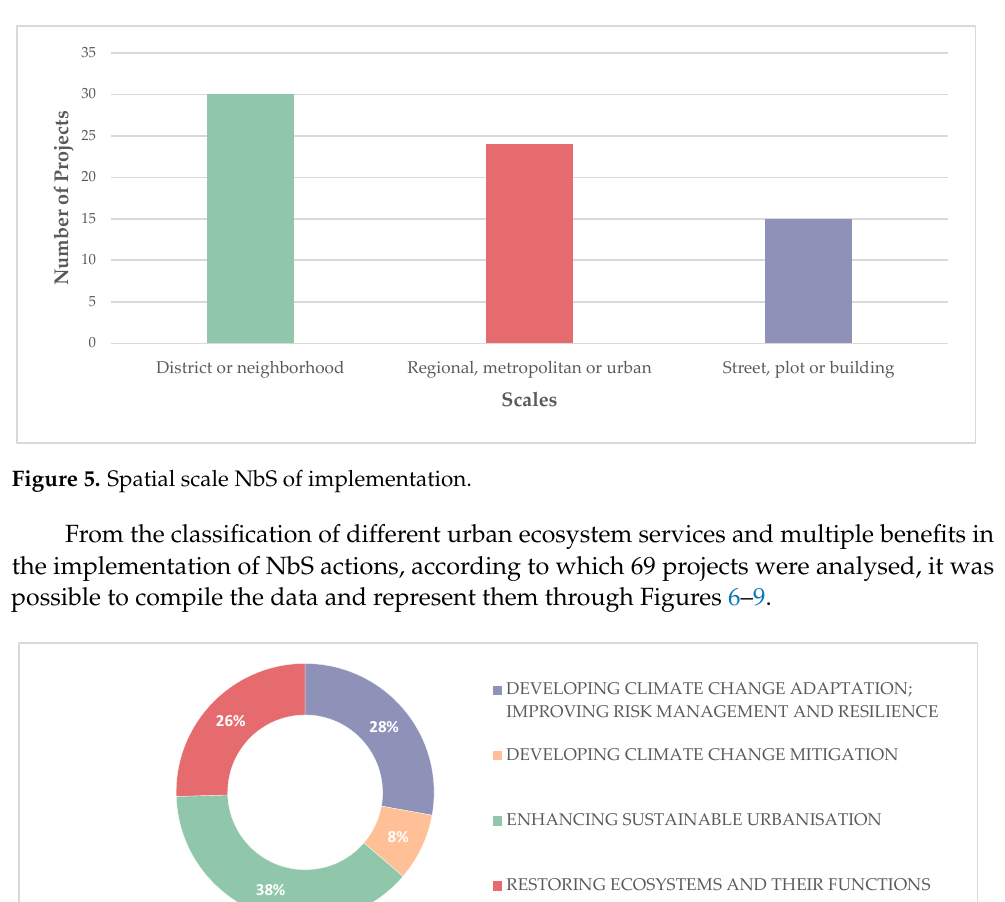
16 of 28 Figure 4. Distribution of NbS urban actions.